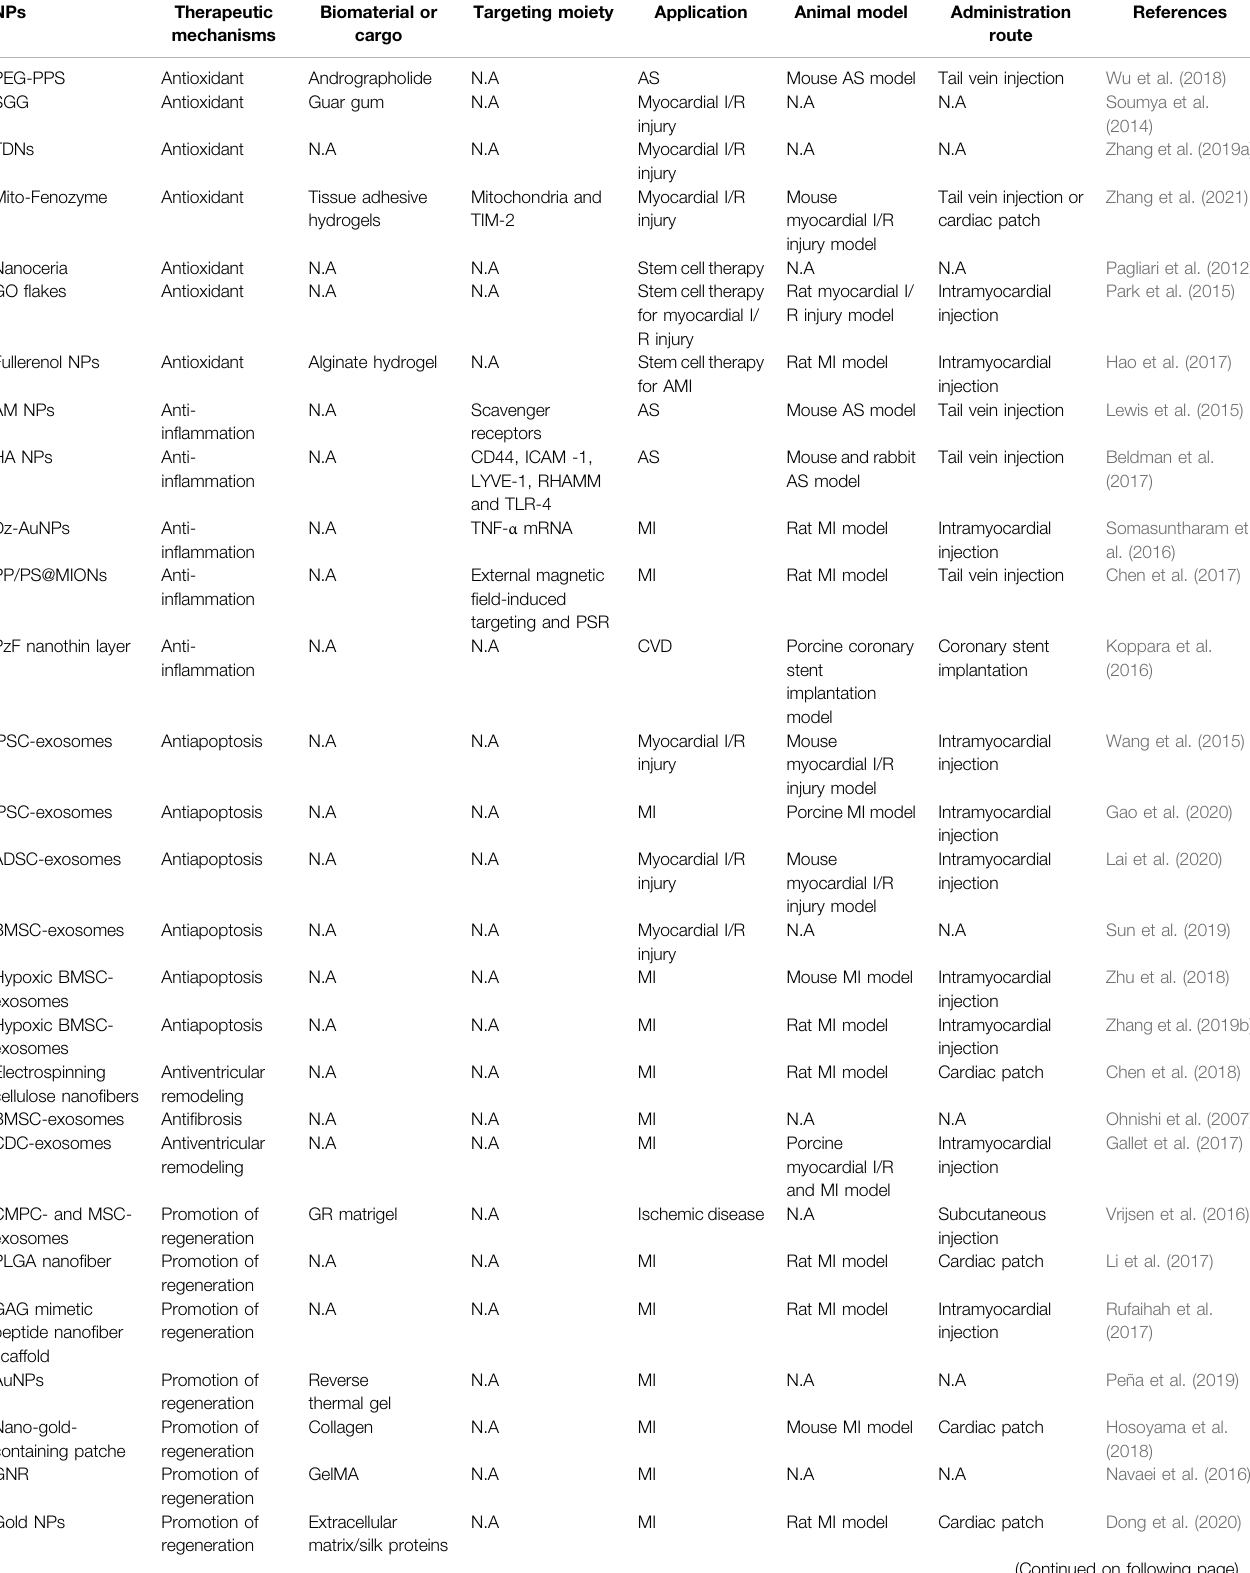
TABLE 1 | Summary of the Nanomedicines used for ASCVD treatment targeting the mechanisms of ASCVD pathophysiology.